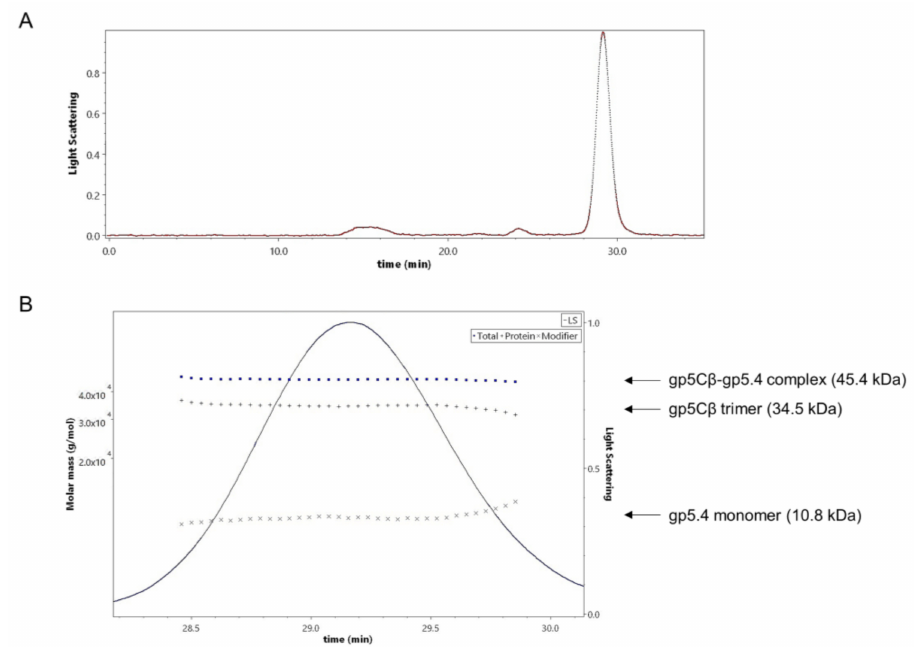
Figure 3. ( A ) Size-exclusion multiangle-light-scattering (SEC-MALS) analysis of gp5C β –gp5.4 complex. A ffi nity-purified complex separated on a Superdex 200 increase where it was eluted at a retention time of 29.16 min. ( B ) Fractions containing the complex were analysed with a 90 ◦ light-scattering detector verifying its composition and the stoichiometry of its components. The complex was composed of 3 molecules of the β helix and one molecule of the gp5.4 protein. Calculated molecular weights (dotted lines, left Y axis) were consistent with theoretical molecular